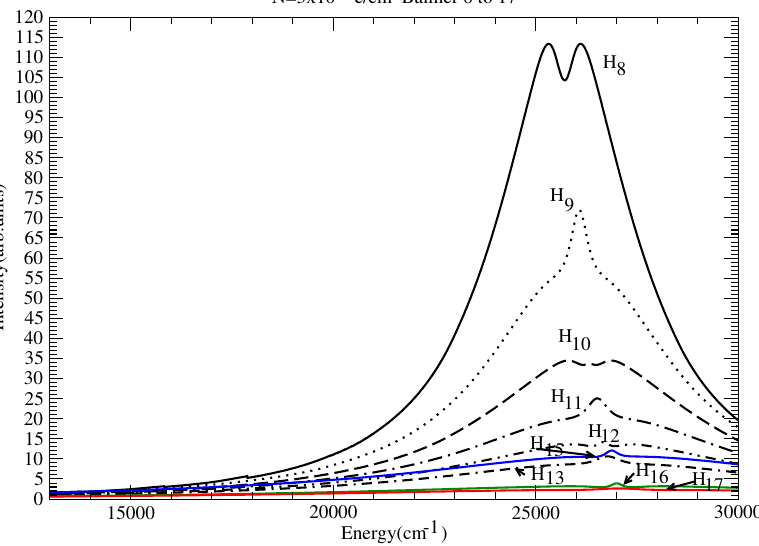
Figure 29. Intensity comparison for Balmer 8 to Balmer 17 at the highest density. Shown are CONVPST profiles for H 8 (solid black), H 9 (dotted), H 10 (dashed), H 11 (dash-dotted), H 12 (dash-double dotted), H 13 (dot double dashed), H 15 (solid blue), H 16 (solid green) and H 17 (solid red).